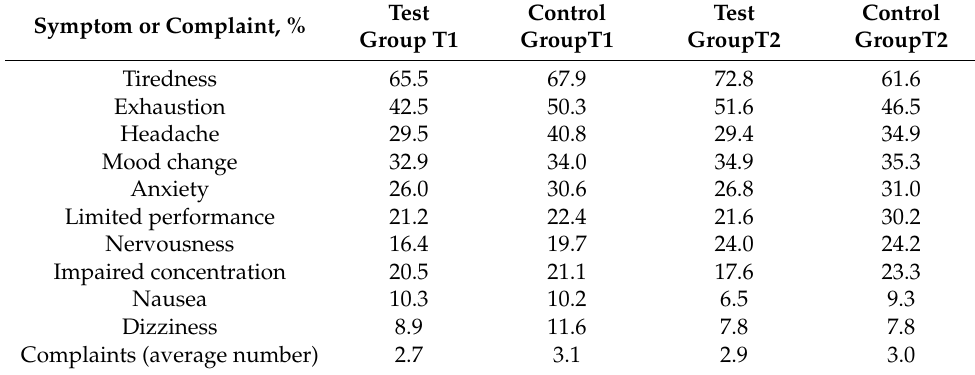
Table 3. Prevalence of symptoms or health impairments (“always” and “often”) in both groups at both measuring time points (T1: three months after moving in; T2: one year later). Test Symptom or Complaint, % Group